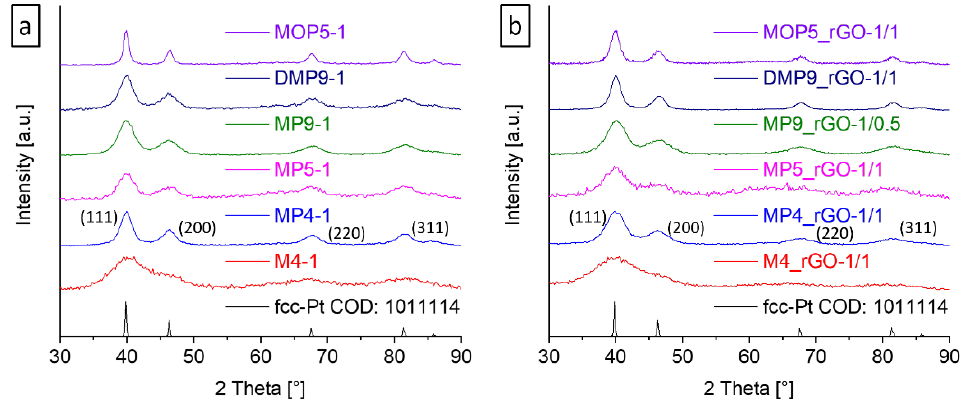
Figure 1. Powder X-ray diffraction (PXRD) patterns of synthesized Pt-NPs ( a ) and Pt-NP@rGO ( b )